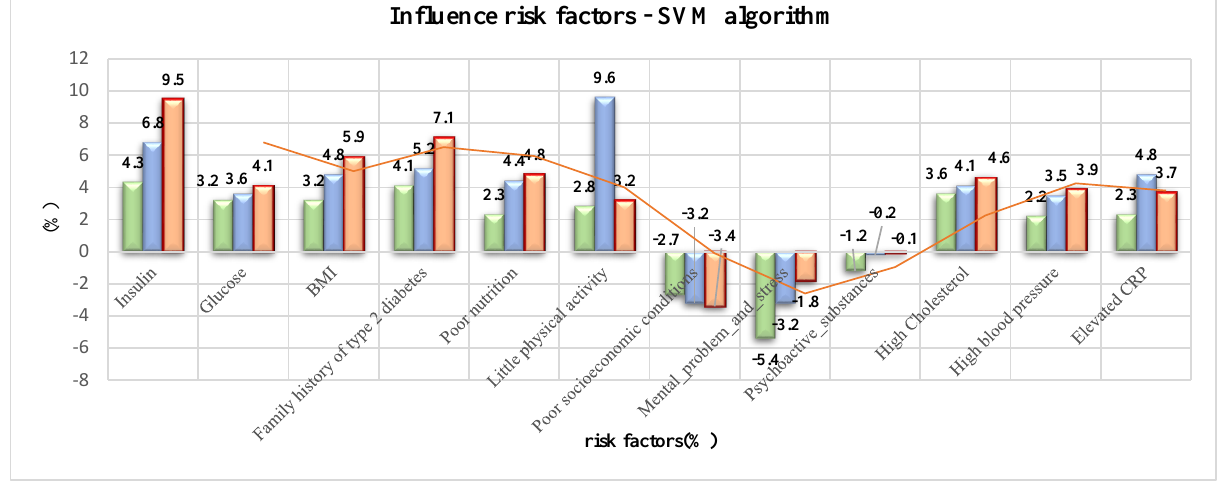
Figure 3. Risk factors—SVM algorithm. Green color: small risk for selected risk factor; Blue color: